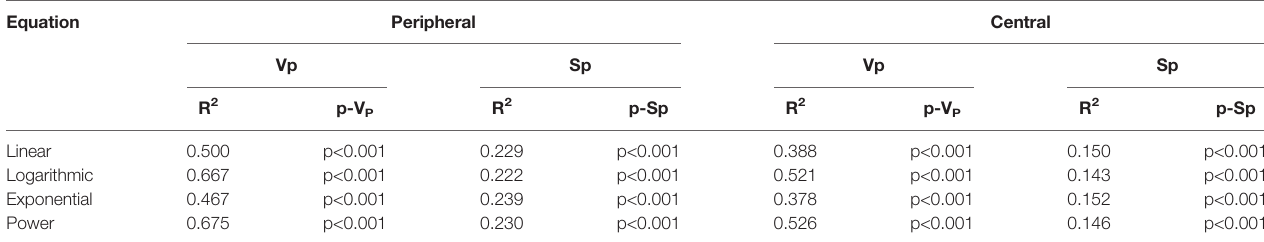
TABLE 2 | Fitting results of GM versus a univariaty (V P , Sp) using different functional forms. Equation